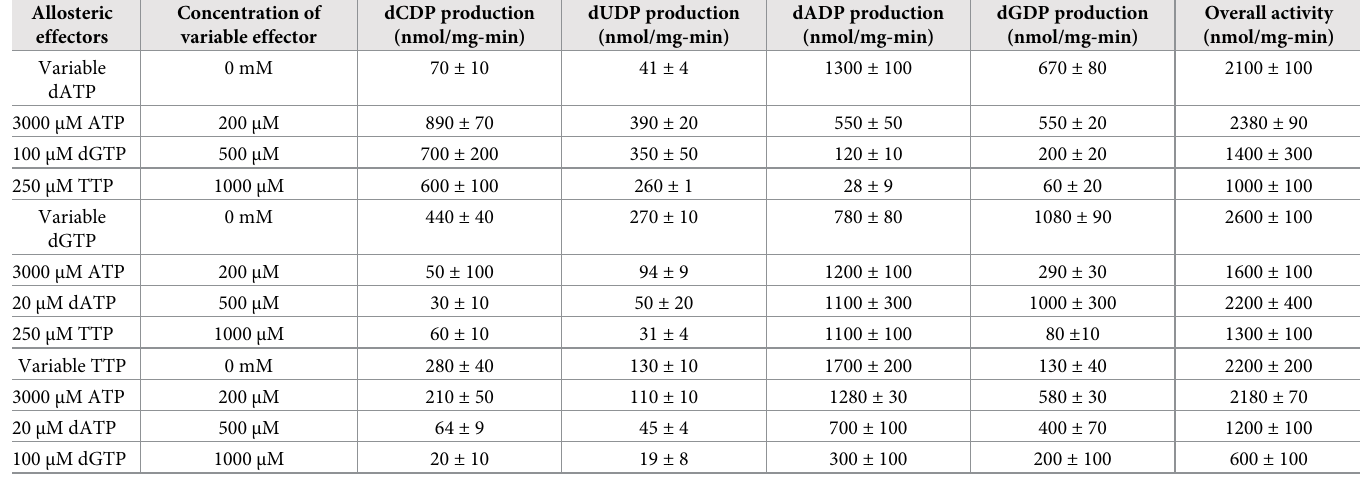
Table 2. Average activities +/- standard error of the mean of assays graphically represented in Fig 8. In addition to the indicated concentration of the allosteric effec- tors shown below in column 1, components and concentrations were as follows: Trx (30 μ M), TrxR (0.5 μ M), NADPH (200 μ M), CDP (70 μ M), UDP (50 μ M), GDP